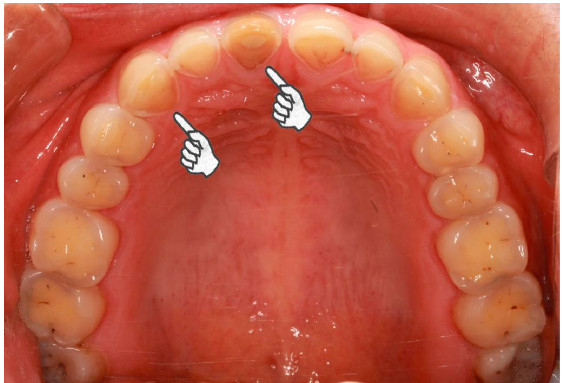
Figure 2. Pathological tooth wear of a 23-year-old female case participant. In general, the female is healthy but she suffers from daily regurgitation and/or heartburn for about two years. She complained of teeth grinding during sleep every day. She rarely experiences exposure to acids from the environment or diet. She hardly rinses or brushes after regurgitation. Extensive tooth wear into dentin was identified, especially on the palatal superficies of upper incisors and canines (pointers). Due to limitations of the case-control and cross-sectional designs, causal relationships cannot be established in the present work. The relationship between GERD and bruxism may be bidirectional, making the mechanisms of tooth wear more complicated. Advanced erosive wear is also associated with pathological reflux in the absence of reflux symptoms [28]. The associations among asymptomatic GERD, bruxism, and tooth wear are worthy of further research. Clinical trials are required to determine whether the management of GERD would have an effect on bruxism. The underlying mechanisms of cervical wear are controversial [2]. The present study found no evidence linking cervical wear to bruxism or GERD. The results are contrary to some findings [22,29], but consistent with the other findings [30,31]. 5. Conclusions The present work identifies a relationship between GERD and bruxism. Special attention should be devoted to this association because both conditions are related to tooth wear. One condition may aggravate the other, resulting in extensive tooth wear. As identified in the present study, long-term GERD is associated with severe tooth wear in bruxism patients. These findings provide important insights on the mechanism of tooth wear in bruxism patients. More importantly, it is time to change the conventional perspective that regards GERD and bruxism as two separate factors associated with tooth wear. Integrative medicine emphasizes that the well-being of the whole person is critical in the prevention of chronic diseases [32]. Dentists are always the first to notice tooth wear in bruxism patients. Any sign of pathological tooth wear due to erosion and/or attrition in bruxism patients should elicit further investigations on reflux symptoms. It is important for dentists to conduct a thorough evaluation of dietary habits, oral hygiene, and medical conditions including GERD to detect the etiological factors of tooth wear in bruxism patients. Supplementary Materials: The following are available online at www.mdpi.com/link, Table S1: Characteristics of cases (with bruxism) and controls (without bruxism), Table S2: Factors associated with bruxism, Table S3: Factors associated with severe tooth wear, Table S4: Conditions of tooth wear for different subgroups. Author Contributions: Conceptualization, all the authors; Methodology, Y.L. (Yuanyuan Li), Y.L. (Yong Long), F.R.T. and J.C.; Software, Y.L. (Yuanyuan Li) and F.Y.; Validation, F.R.T. and J.C.; Formal Analysis, Y.L. (Yuanyuan Li), F.Y., L.N., W.H., Y.L. (Yong Long) and F.R.T.; Investigation, Y.L. (Yuanyuan Li), L.N. and W.H.; Resources, F.R.T. and J.C.; Data Curation, L.N. and Y.L. (Yong Long); Writing-Original Draft Preparation, Y.L. (Yuanyuan Li) and F.Y.; Writing-Review & Editing, all the authors; Visualization, Y.L. (Yuanyuan Li), F.R.T. and J.C.; Supervision, F.R.T. and J.C.; Project Administration, F.R.T. and J.C.; Funding Acquisition, F.R.T. and J.C.